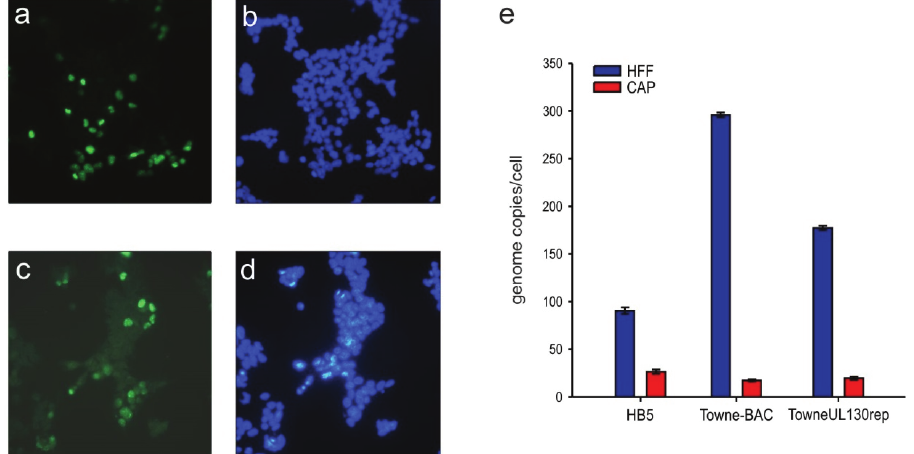
Figure 2. IF-analysis and viral genome uptake of CAP adh. , infected with HCMV laboratory strains. CAP adh. were infected with strains Towne (Towne-BAC; a , b ) or AD169 (HB5; c , d ), respectively at an m.o.i. of 1. 2 d p.i., cells were stained for the expression of IE1 by IF ( a , c ) or were stained by DAPI ( b , d ); Genome uptake following infection with Ad169 (HB5), Towne (Towne-BAC) or TowneUL130rep (control) was measured 6 h p.i. by quantitative PCR analysis ( e ). The genome uptake of HFF, infected with the respective strains was taken along for control. Error bars represent means of three technical replicates.